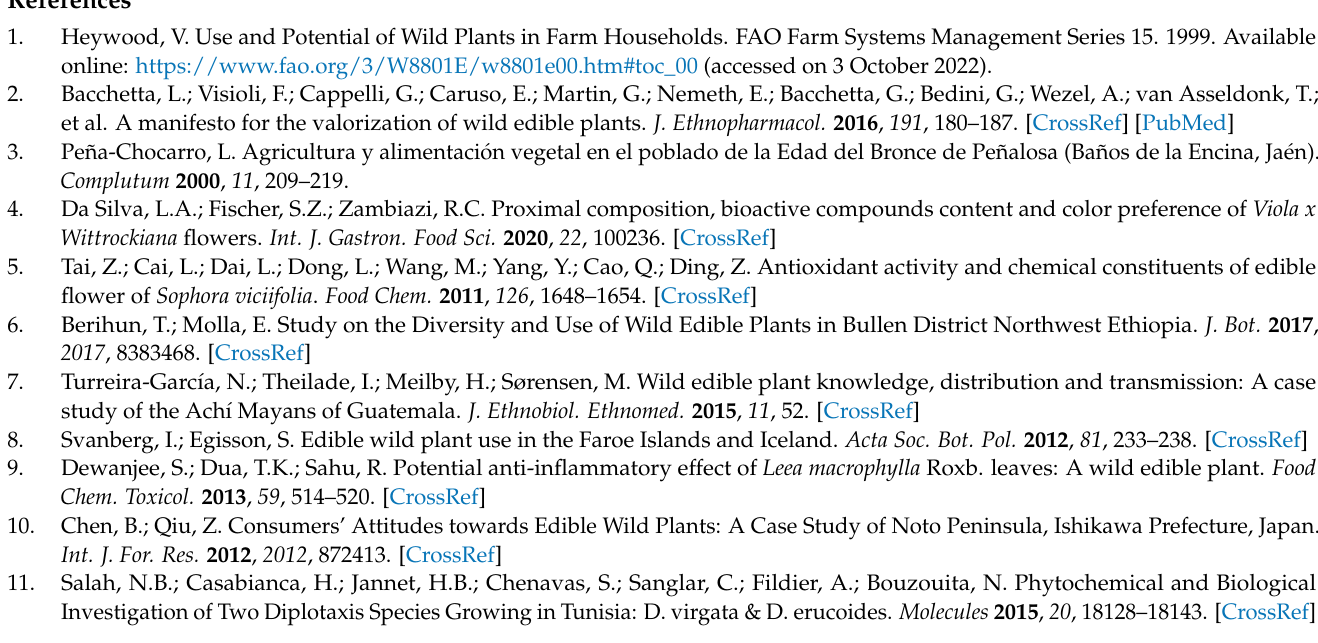
Table S2: Organic acids content in Wild Edible Plants, WEPs; Table S3: Daily value of minerals recommended by Food & Drug Administration (FDA); Table S4: Mineral elements in Wild Edible Plants, WEP’s.